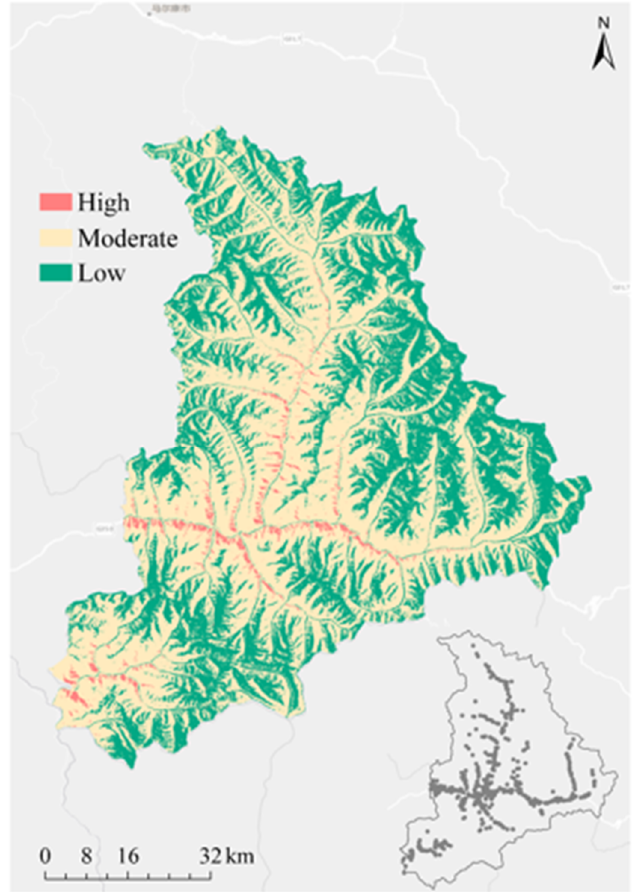
Figure 8. Landslide susceptibility map of the study area, the bottom right corner of the picture is a landslide inventory map.